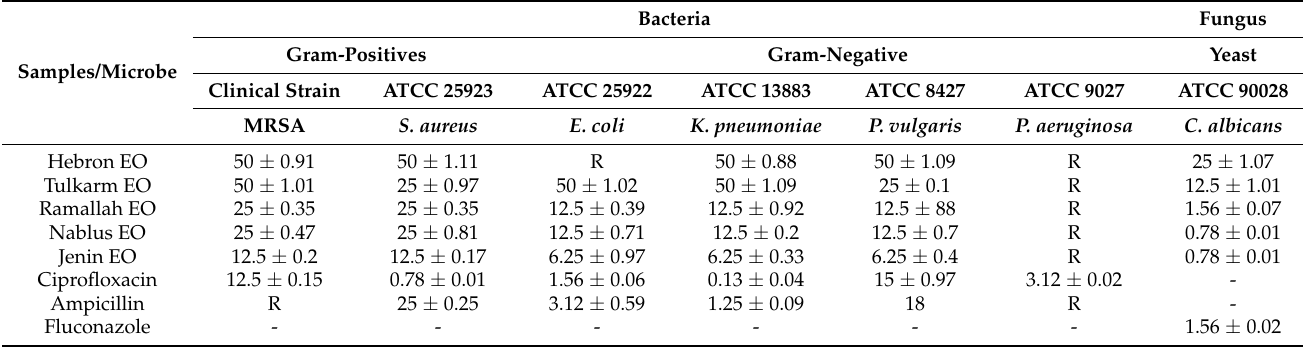
Table 2. Antimicrobial activity MIC values ( µ g/mL) of R. officinalis essential oils collected from five different Palestinian